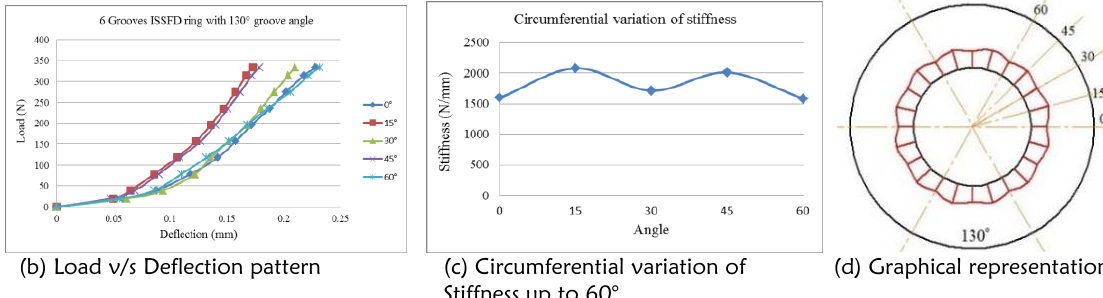
Figure 11: Details of the results for 6- grooves ISSFD ring with 130° groove angle